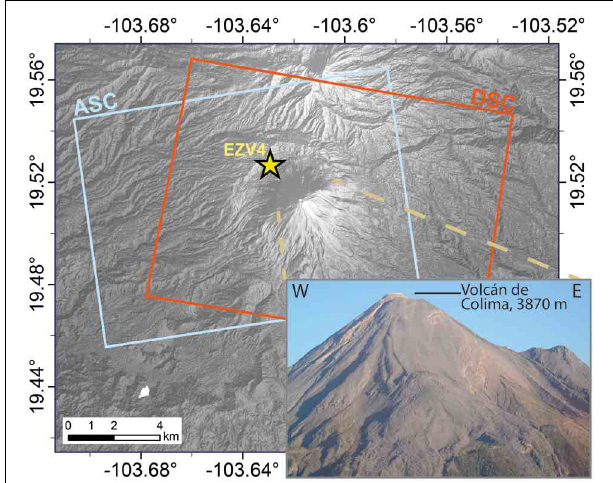
FIGURE 1 | Location map and overflight photograph of Volcán de Colima. The steep-sloped volcanic cone is approximately 4–6km wide, and completely covered by both the ascending and descending TerraSAR-X satellite data (blue and red boxes in map view). The yellow star marks the seismic station EZV4 described in this